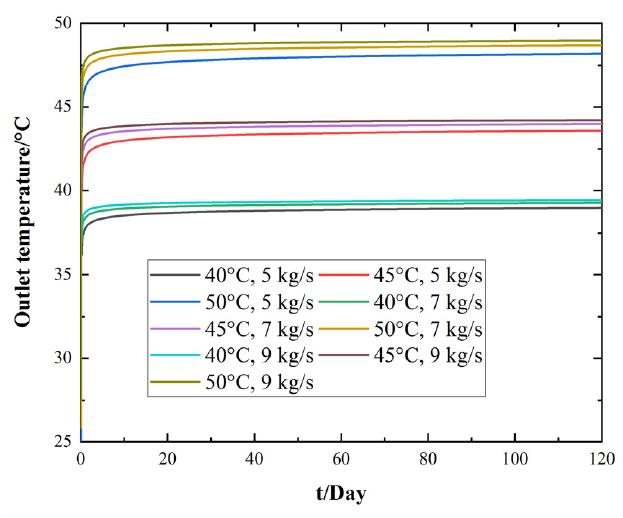
Figure 7. Outlet temperature of water during the cooling season.